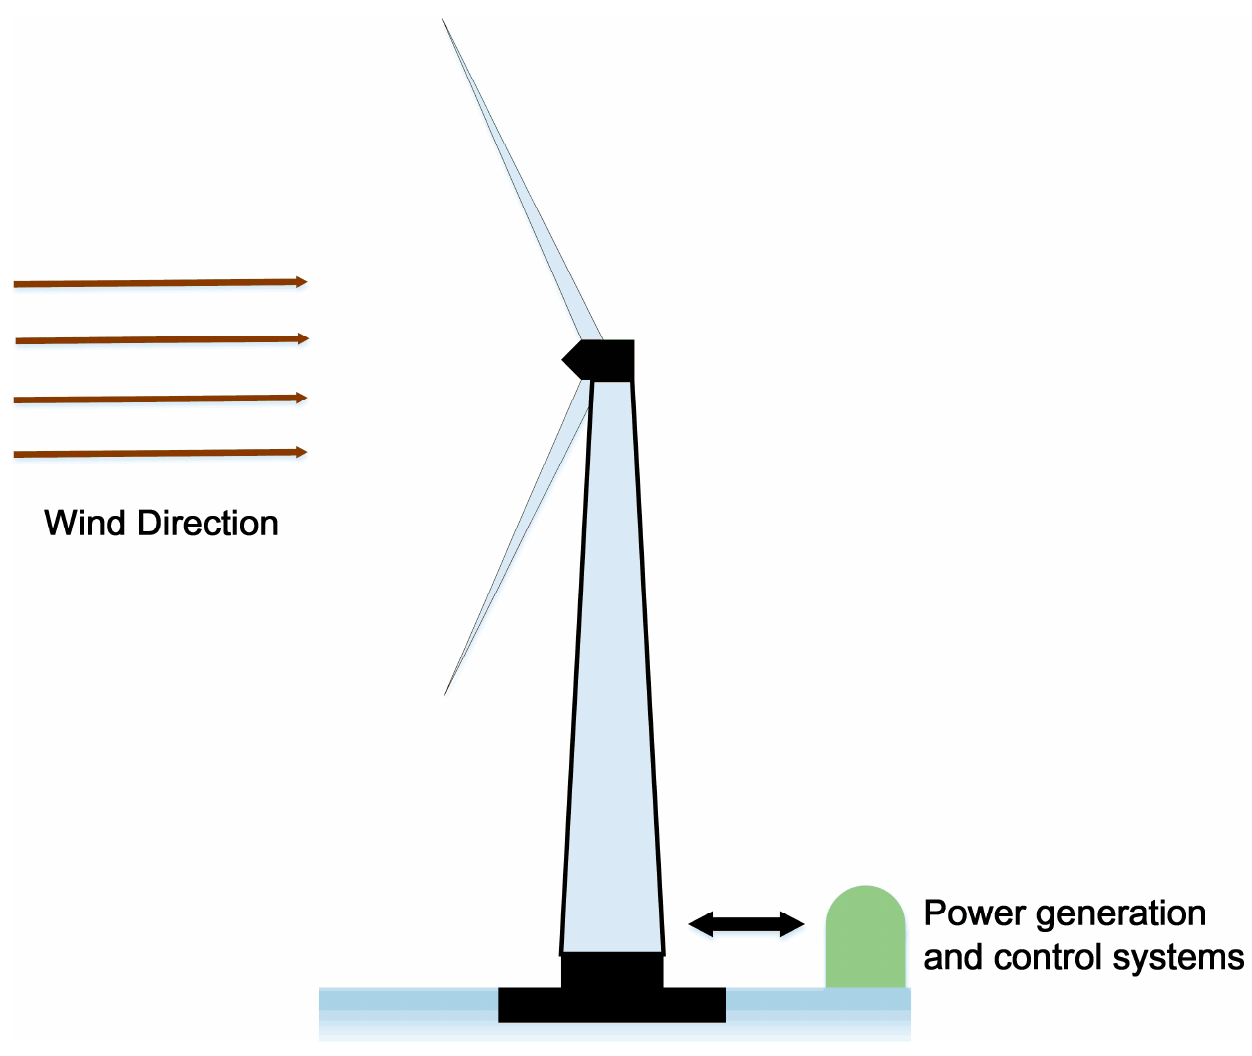
Figure 2. Schematic diagram of wind speed prediction and control. The control system made a forecast of the next moment wind speed according to the current wind speed conditions and adjusted the wind turbine in time.